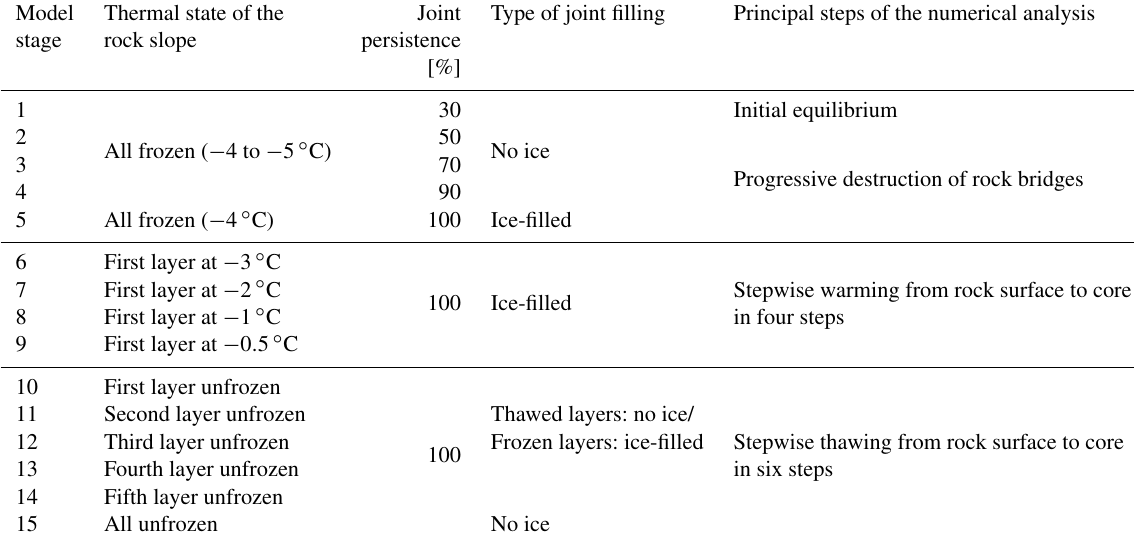
Table 6. Modelling strategy for the Zugspitze summit crest. The model was run with varying rock mass temperature, joint persistency and filling. The temperature levels for gradual warming were as follows: − 4, − 3, − 2, − 1 and − 0 . 5 ◦ C.